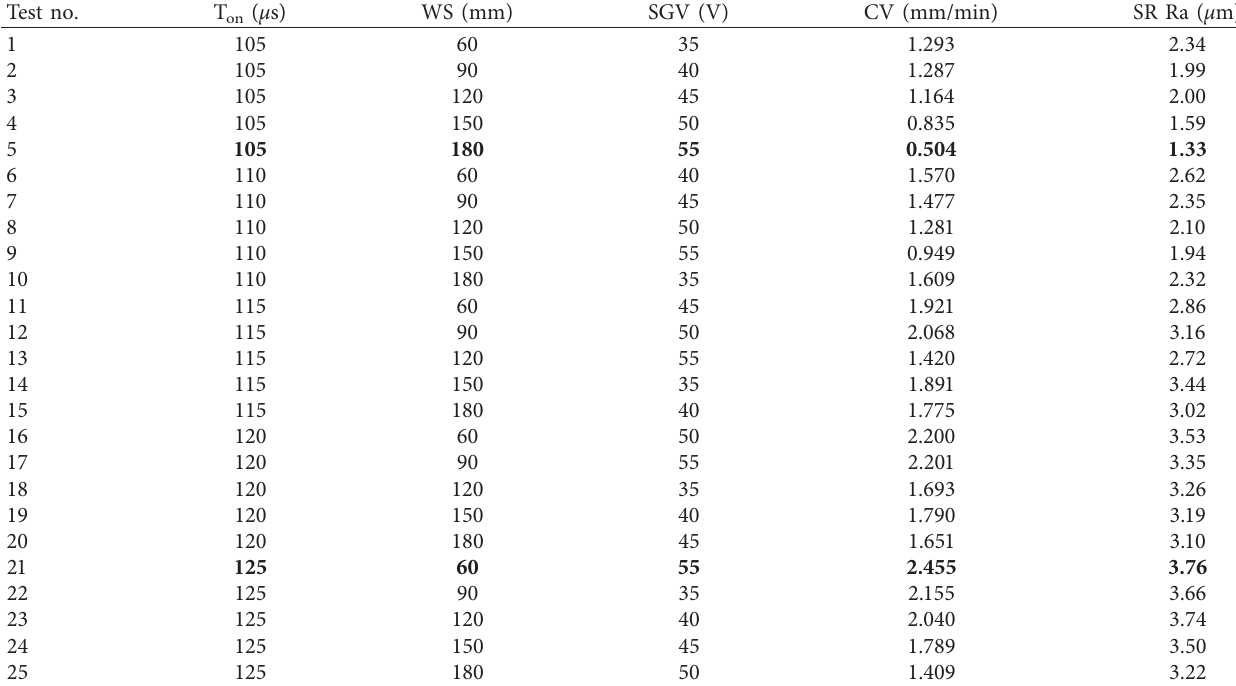
Table 3: Response at different machining parameters.